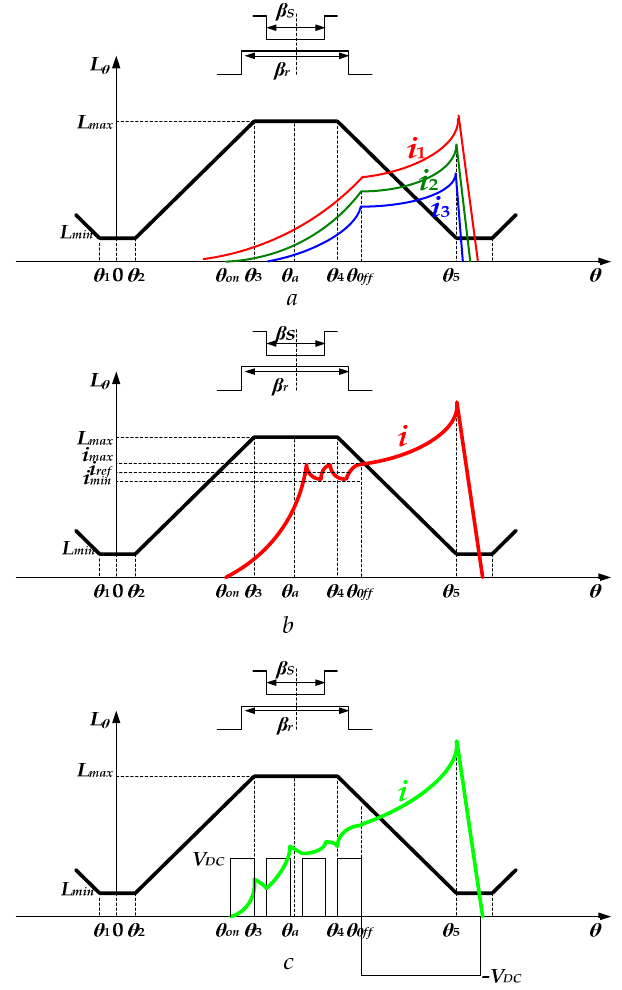
Figure 3. The waveforms of the phase current using three control methods. ( a ) APC control method; ( b ) CCC control method; ( c ) PWM control method.